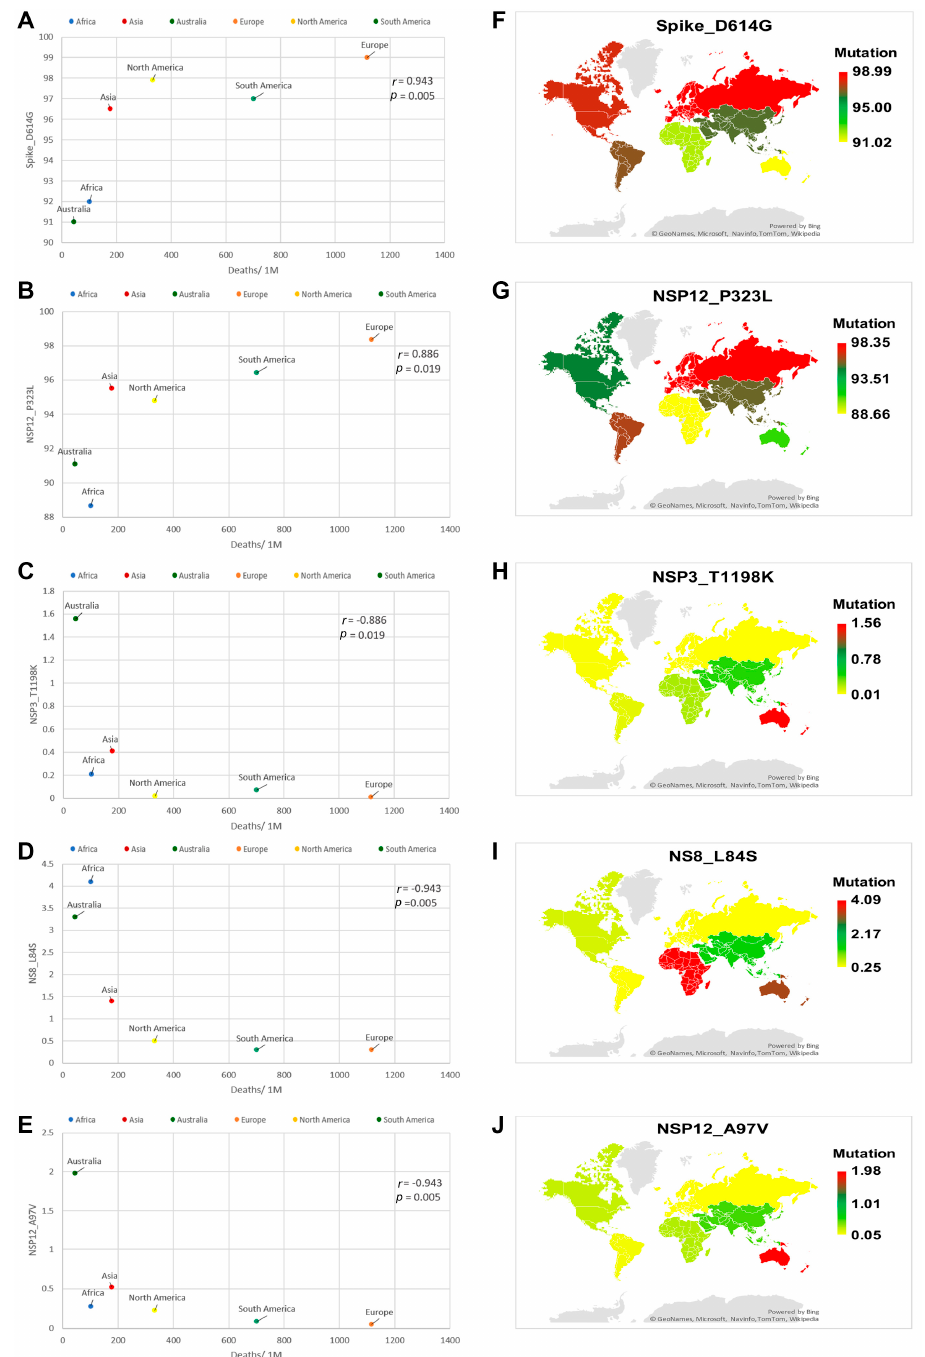
Figure 4. Correlation analysis and global mapping of mutations having a positive correlation with deaths per million among different world continents. ( A ) Spearman’s correlation between Spike_D614G mutation and deaths per million, ( B ) Spearman’s correlation between NSP12_P323L mutation and deaths per million, ( C ) Spearman’s correlation between NSP3_T1198K mutation and deaths per million. ( D ) Spearman’s correlation between NS8_L84S mutation and deaths per million. ( E ) Global mapping of NSP12_A97V mutation having a positive correlation with deaths per million. ( F ) Global map- ping of Spike_D614G mutation having a positive correlation with deaths per million. ( G ) Global mapping of NSP12_P323L mutation having a positive correlation with deaths per million. ( H ) Global mapping of NSP3_T1198K mutation having a negative correlation with deaths per million. ( I ) Global mapping of NS8_L84S mutation having a negative correlation with deaths per million. ( J ) Global mapping of NSP12_A97V mutation having a negative correlation with deaths per million r: Spearman’s correlation coefficient. p : p